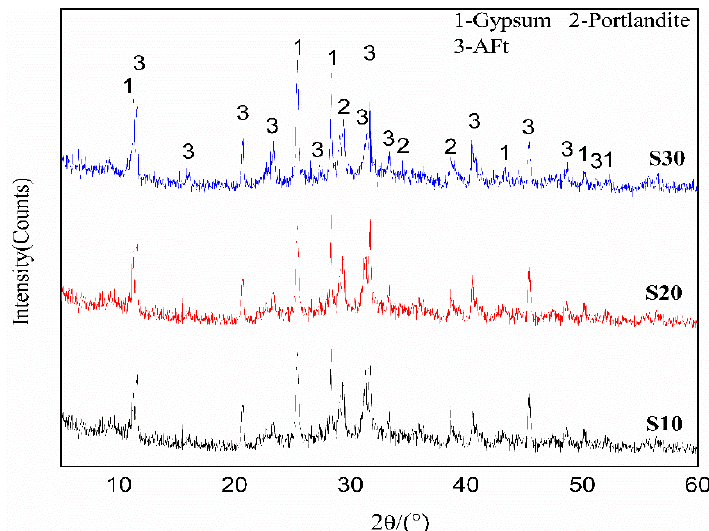
Figure 3. XRD spectra of the samples (S10, S20, S30).